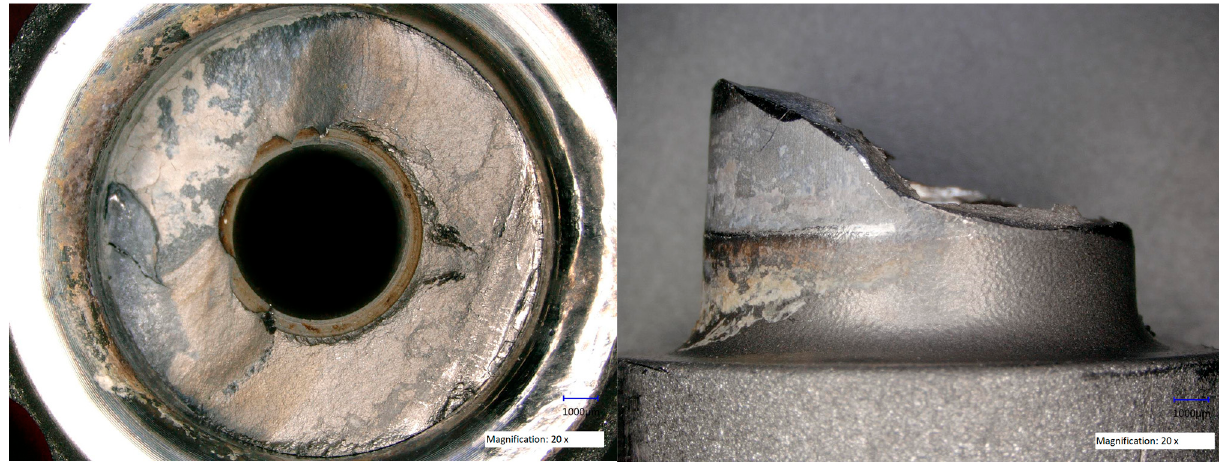
Figure 3. Neck piece ( left ) and lateral view of the broken taper ( right ).